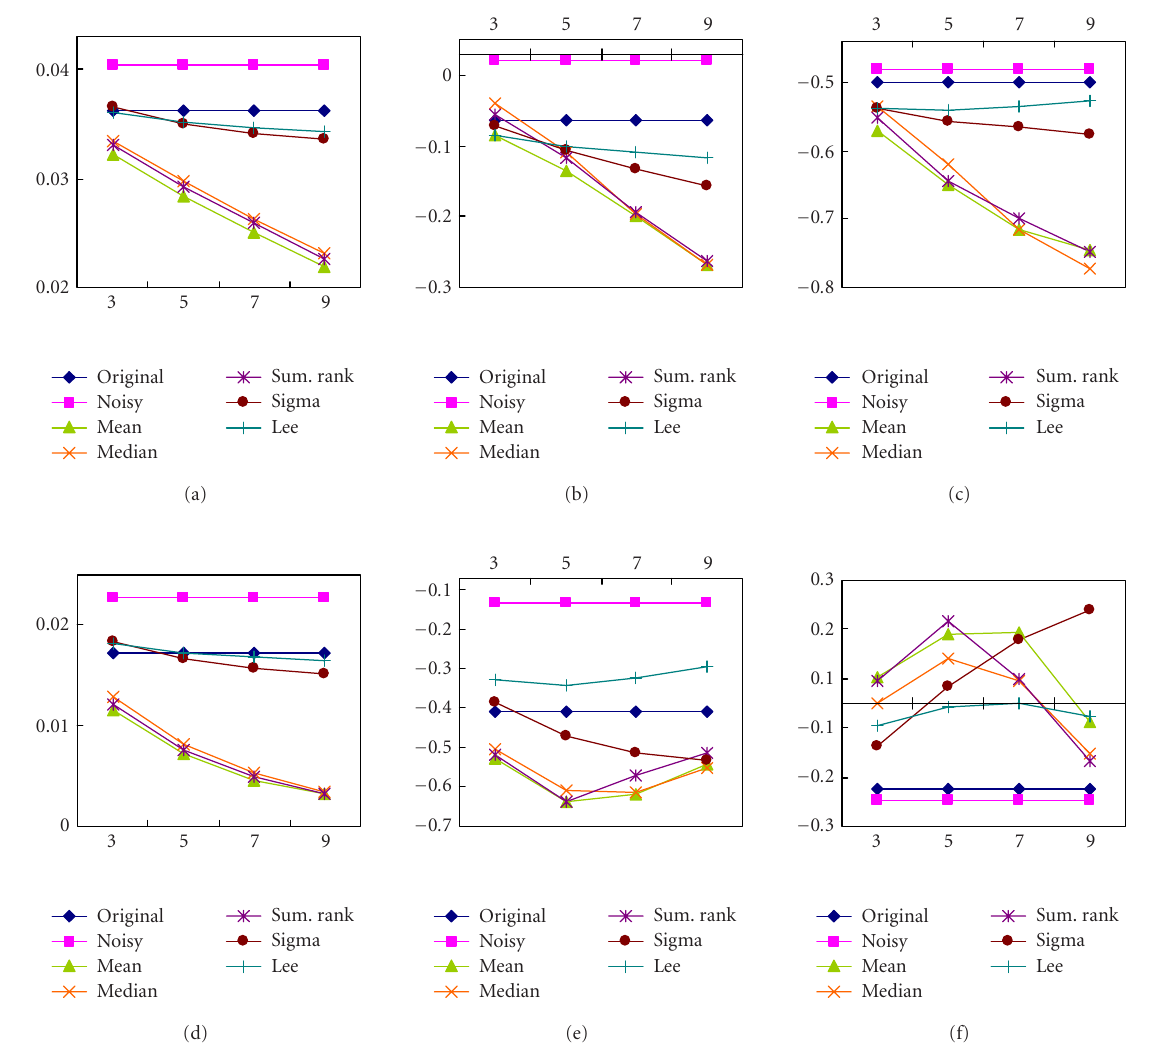
Figure 2: Diagrams of statistical characteristics (vertical axis): (a), (d) the relative local variance, (b), (e) the skewness, and (c), (f) the kurtosis of the textural fragment in the right bottom part ((a) , (b), and (c)) and in the left bottom part ((d), (e), and (f)) of the test image (Figure 1) corrupted by Gaussian multiplicative noise ( σ 2 µ = 0 . 005) depending on the square sliding window side size (horizontal